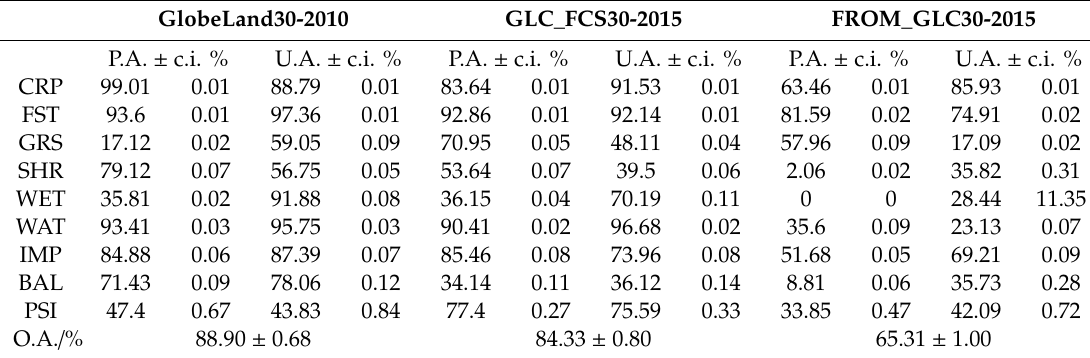
Table 4. Related accuracy measures based on the adjusted confusion matrix of three products at the 95% confidence